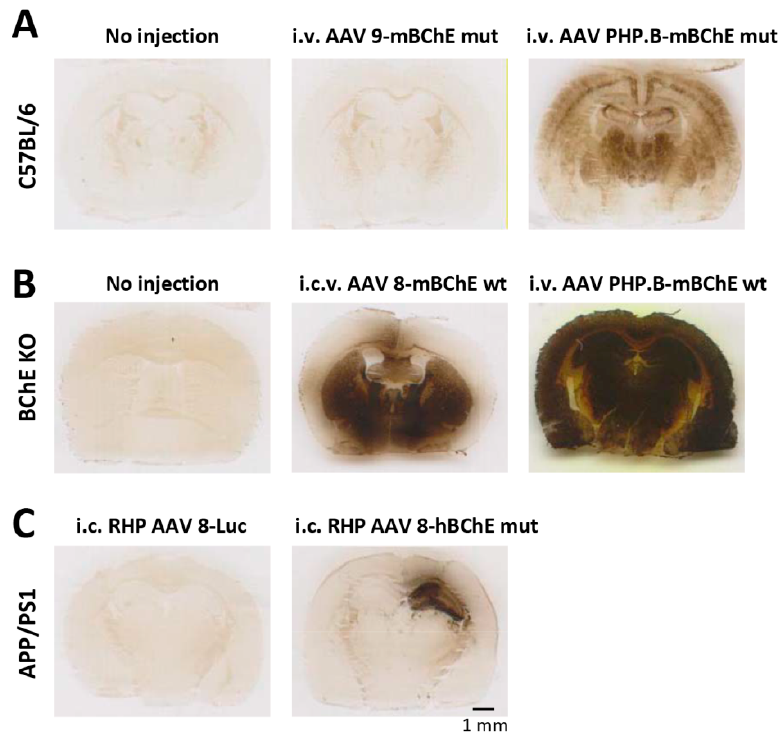
Figure 1. Viral gene transfer of enzyme in brains of C57BL/6, BChE KO, and APP/PS1 mice. ( A ) 2 month-old C57BL/6 mice were given i.v. injection of AAV 9 or AAV PHP.B vector coding for mouse BChE mutant at a dose of 1 × 10 13 particles. Brains were harvested 3 weeks after injection. ( B ) 10-week-old BChE KO mice received AAV 8 vector doses of 3 × 10 12 particles delivered stereotaxically into the intracerebroventricular (“i.c.v.”) space or tail vein i.v. injection of 1 × 10 13 viral particles of AAV PHP.B vector coding for the same enzyme. Brains were collected 5 months or 3 weeks after injection, respectively. ( C ) APP/PS1 mice received stereotactic intracerebral (“i.c.”) injection of AAV 8-hBChE mutant or AAV 8-Luc at a dose of 3 × 10 12 particles at 2 months of age, using coordinates for the right hippocampus (“RHP”). Six months after injection, brains were harvested for BChE activity staining.